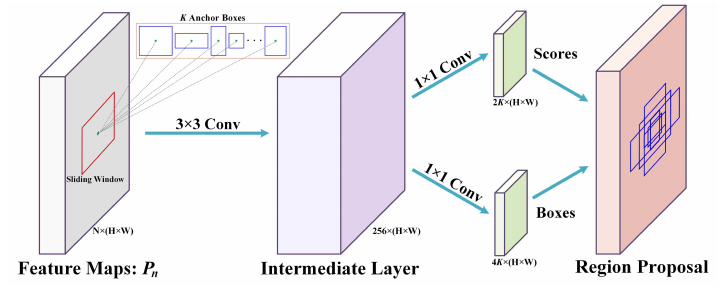
Figure 8. Architecture of the RPN.